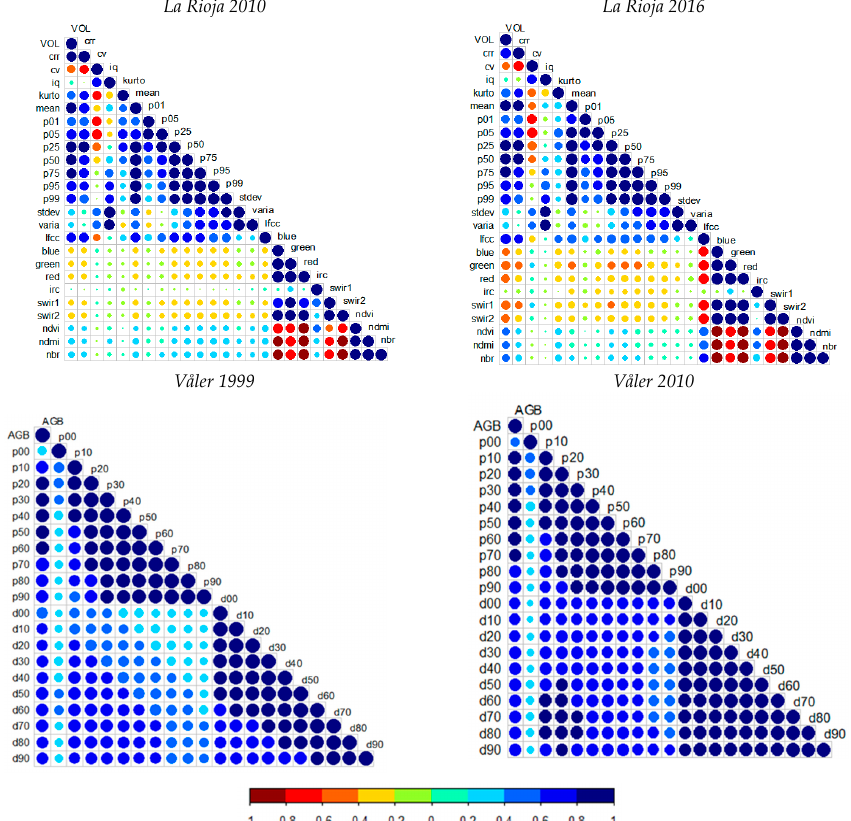
Figure 4. Correlation among dependent and independent variables. Note: Height percentiles (ranging from the 0th to 99th percentile: p00, p01, p05, …, p99); canopy densities (ranging from the 0th to 90th canopy density: d00, d10, …, d90); lfcc: Forest canopy cover; varia: Variance; stdev: Standard deviation; kurto: Kurtosis; iq: Interquartile range; cv: Variation coefficient; crr: Canopy relief ratio; Landsat individual bands (blue, green, red, near infrared (irc) and two shortwave infrared (swir1 and swir2) ndvi: Normalized difference vegetation index; nbr: Normalized burn ratio; and ndmi: Normalized difference moisture index.